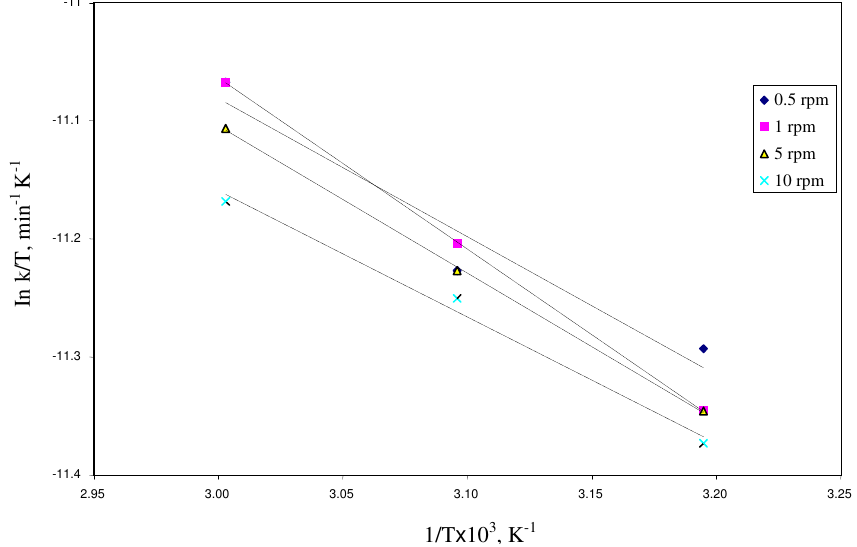
Figure 6. Plots of ln k/T vs .1/T of the propellant slurry at different shear rate.